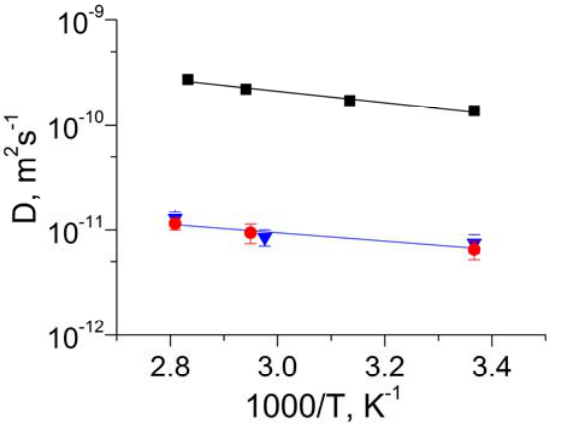
Figure 4. Temperature dependences of the methane self-diffusion coefficient measured by PFG NMR for the effective diffusion time 9 ms in 6FDA/BPDA ( ■ ), Matrimid Sample 1 ( ● ), and Matrimid Sample 2 ( ▼ ). Lines show the fit to the Arrehenius law (Equation